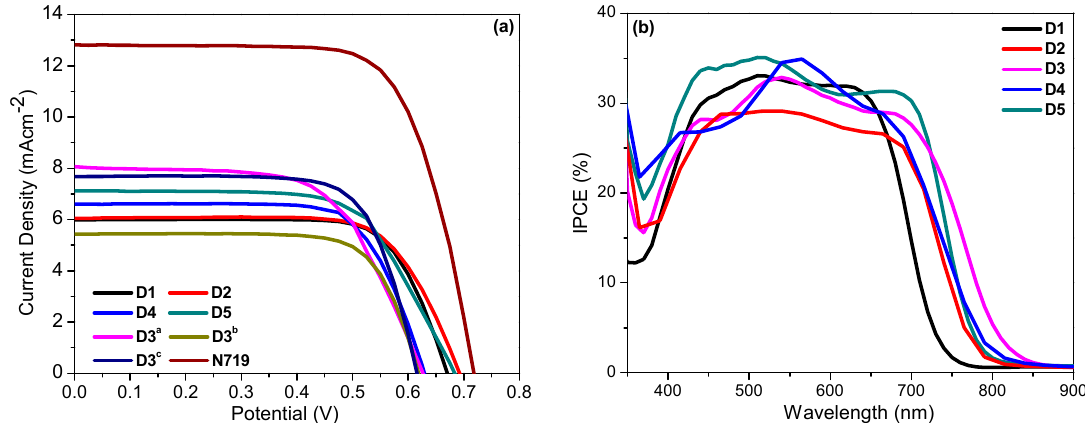
Figure 4. ( a ) Photocurrent density-voltage (J-V) curves and ( b ) Incident photon-to-electron conversion e ffi ciency (IPCE) spectra of the dyes D1 to D5 . Table 2. Photovoltaic performance of dyes D1 – D5 compared with N 719 under 1 sun AM 1.5 G illumination.